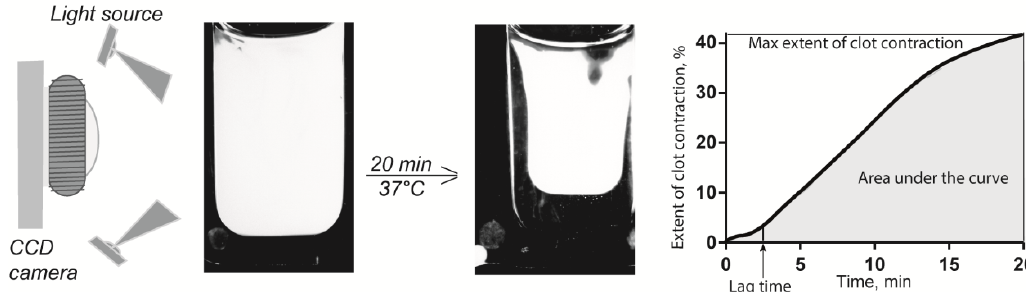
Figure 5. Schematic of the optical system used to quantify clot contraction. The change in clot size is registered automatically by the CCD camera and presented as a kinetic curve that is characterized by numeric parameters.